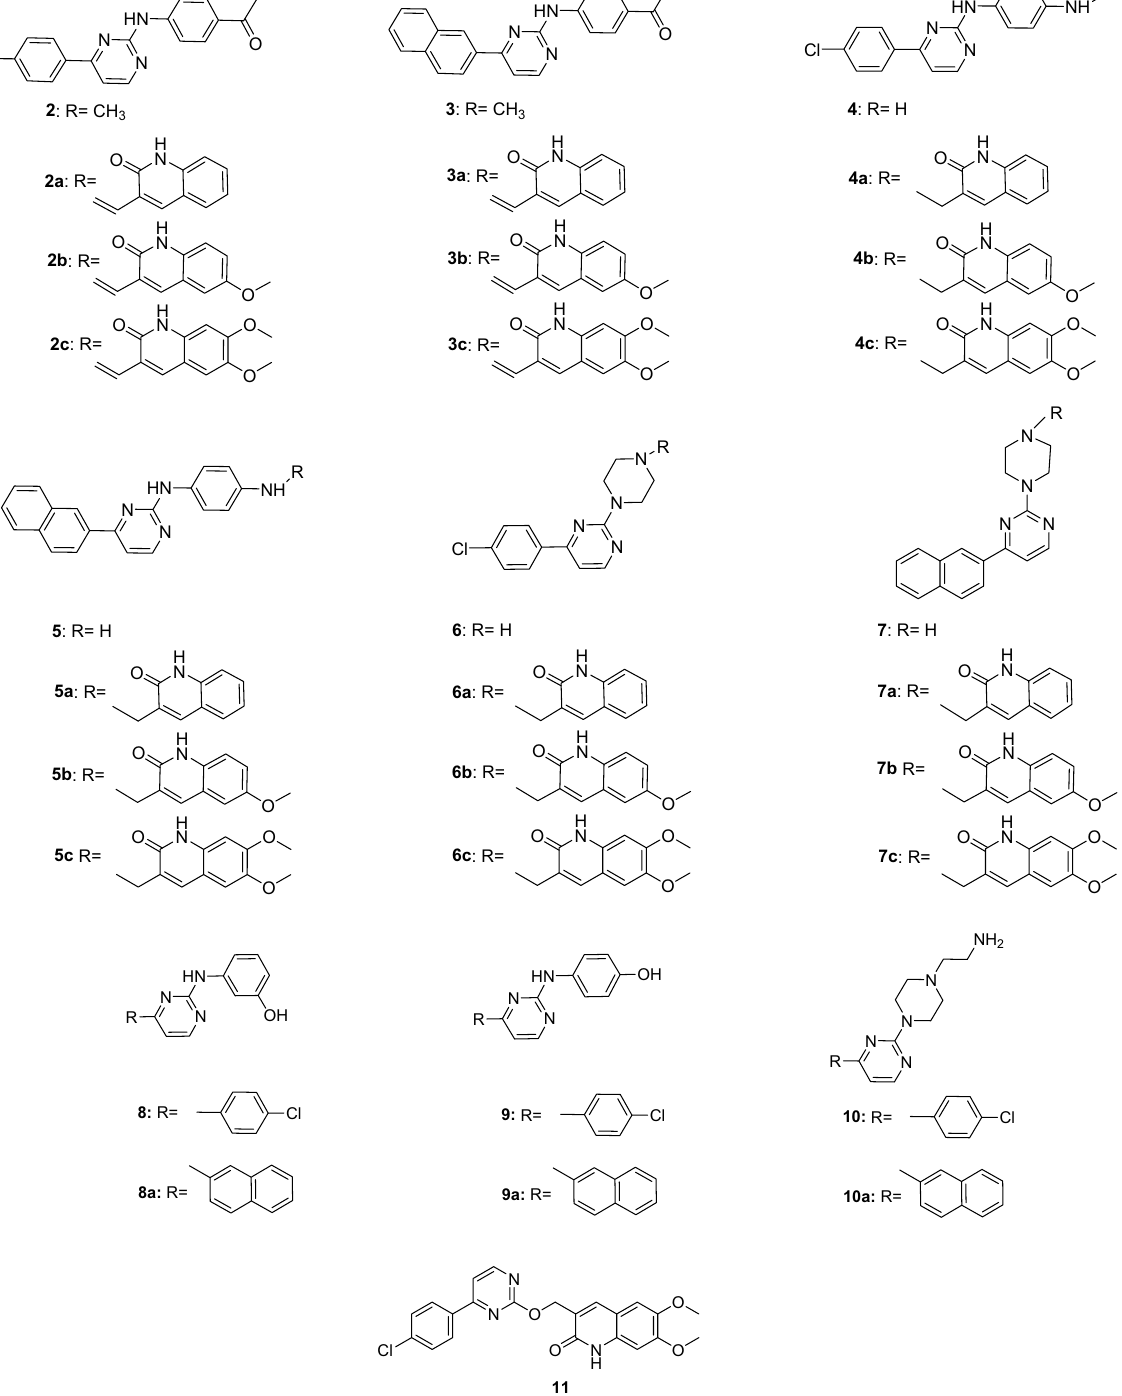
Figure 1. Chemical structures and labelling of the tested